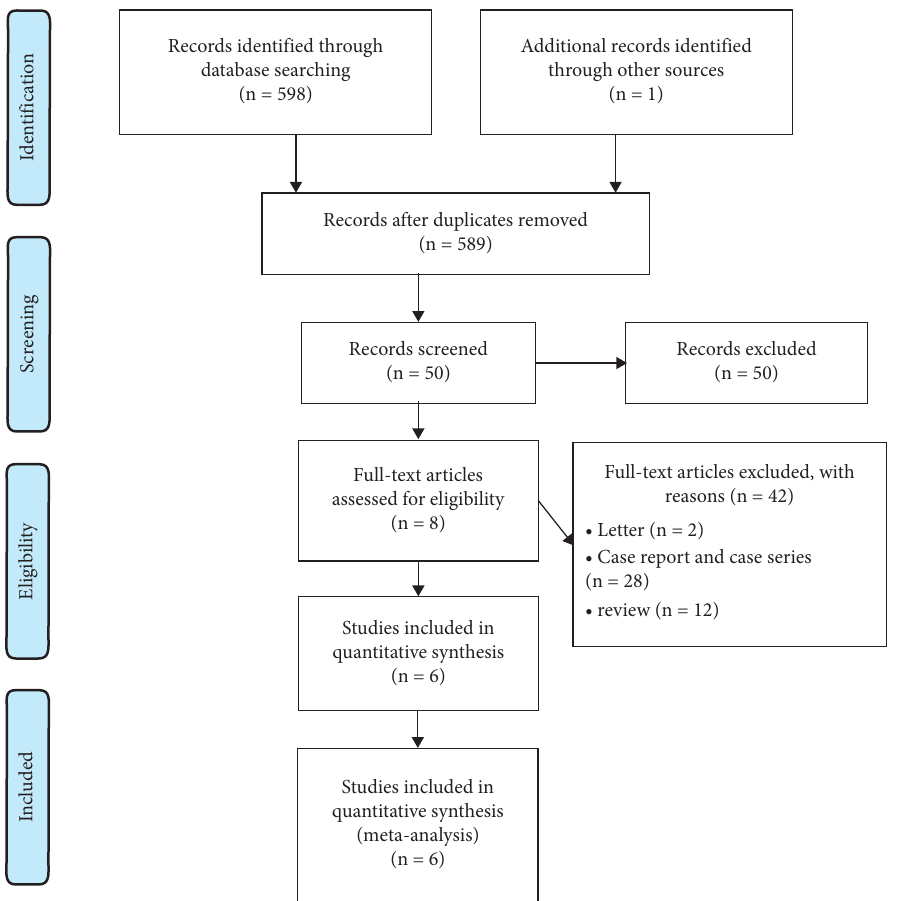
Figure 1: Flow diagram of the